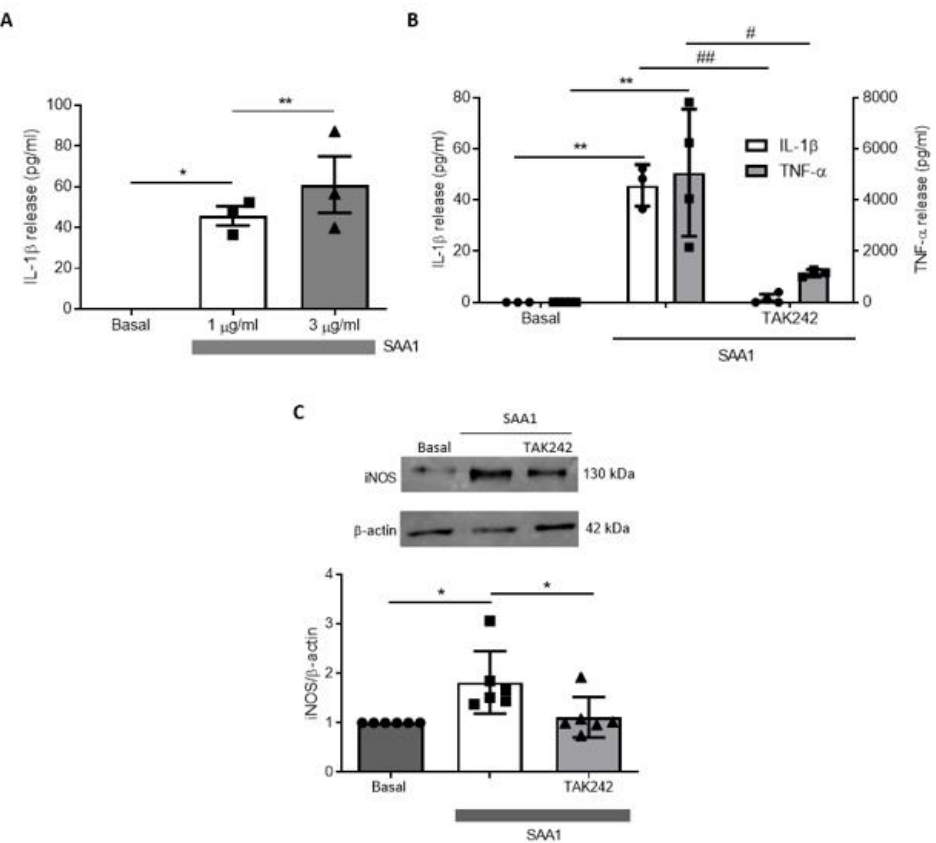
Figure 4. TAK242 treatment prevented the increase of proinflammatory parameters induced by SAA1 in primary mixed glial cultures. ( A ) Glial cultures were treated with SAA1 (1 and 3 µg/mL) with or without TAK242 (1 µM) during 24 h. ELISA revealed a significant increase of IL-1β release to culture medium (n = 3). * p < 0.05, ** p < 0.01, 1-way ANOVA test with Tukey’s multiple comparisons test. ( B ) ELISA analysis revealed that TAK242 prevented the increase of IL-1β (n = 4) and TNF-α (n = 5) produced by SAA1. * p < 0.05, ** p < 0.01, # p < 0.05, ## p < 0.01,1-way ANOVA test with Tukey’s multiple comparisons test. ( C ) Representative immunoblot and quantification of iNOS expression in cultures treated with SAA1 with or without TAK242 (n = 6). * p < 0.05, 1-way ANOVA test with Tukey’s multiple comparisons test. Data of all exper- iments are represented as mean ± SD.